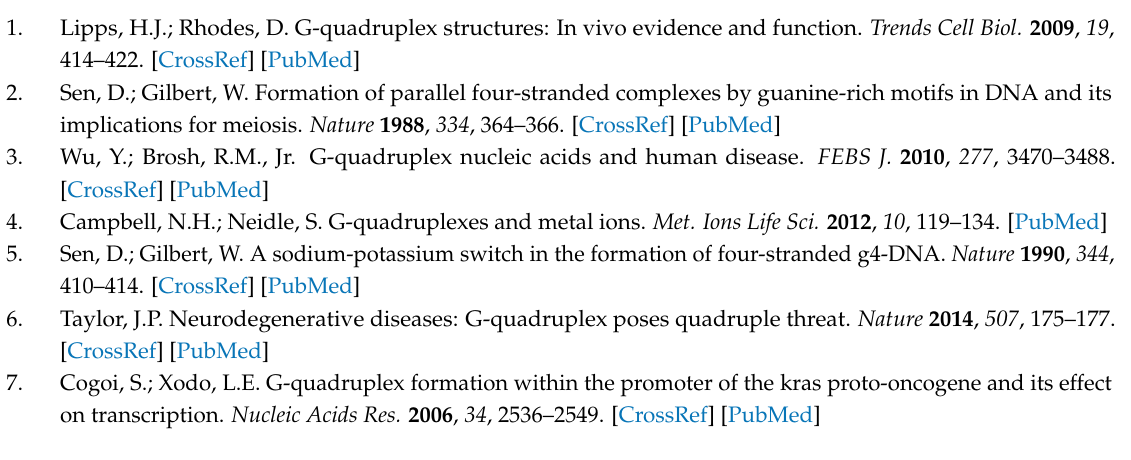
Supplementary Materials: The following are available online. Table S1: Oligonucleotides used in this study, NMR Figures: 1 H and 13 C-NMR characterization of all compounds presented in the main